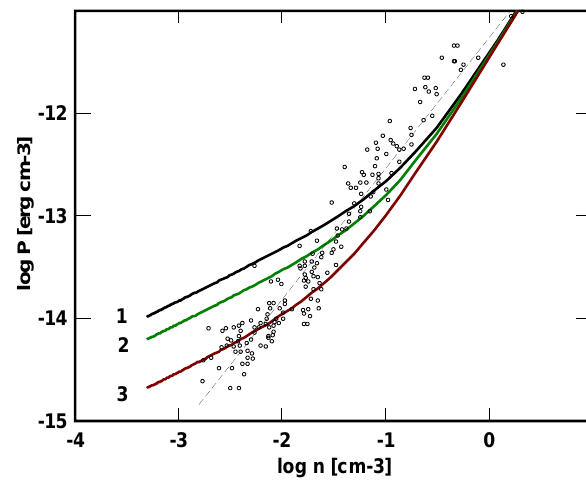
Fig. 1. Plotted is the logarithm of the solar wind pressure P 1 versus the logarithm of the density n 1 at 3 = 1 · 10 − 3 and T 1 , 0 = 5 · 10 4 K for different values of 1α = α 1 − α 2 , i.e. for 1: 1α = 50 , 2: 1α = 30 , 3: 1α = 10 .